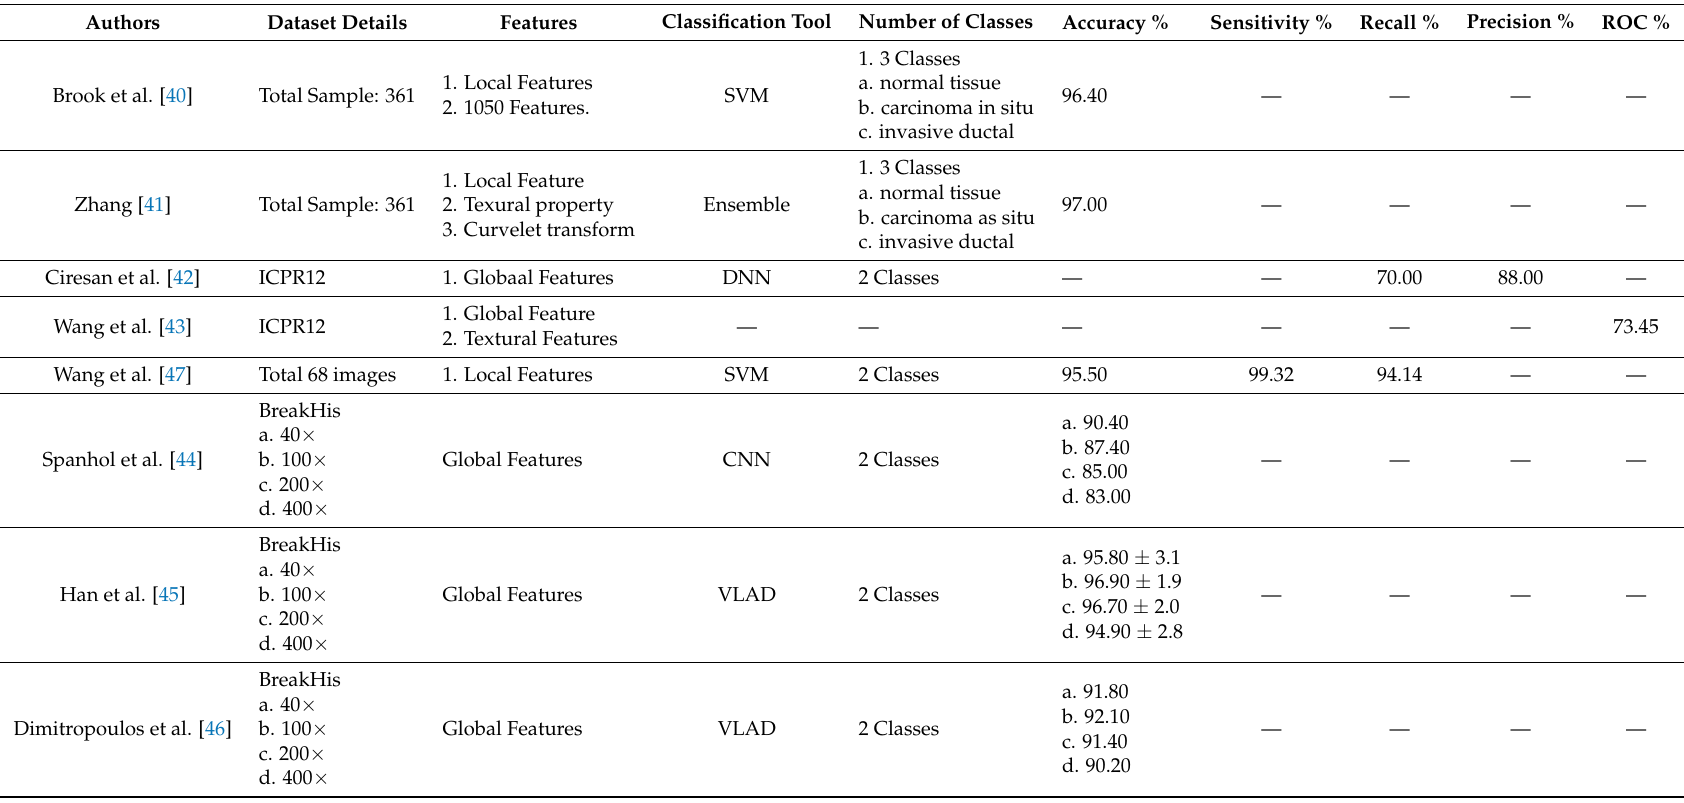
Table 8. Summary of a few recent findings of Histopathological breast-image